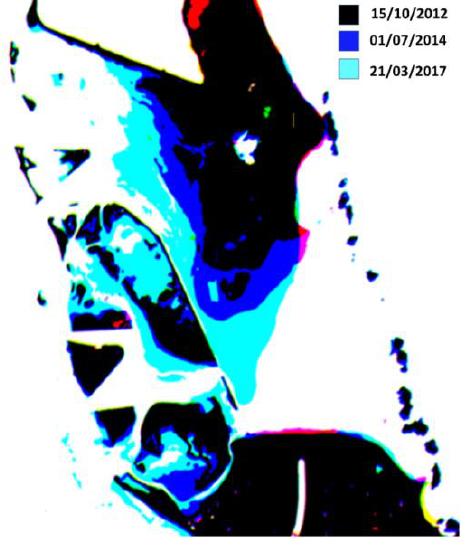
Figure 10. Map showing the differences among the dates 15 October 2012, 23 May 2014, and 21 March 2017. It was produced using Pleiades images of the Encañizada channel.